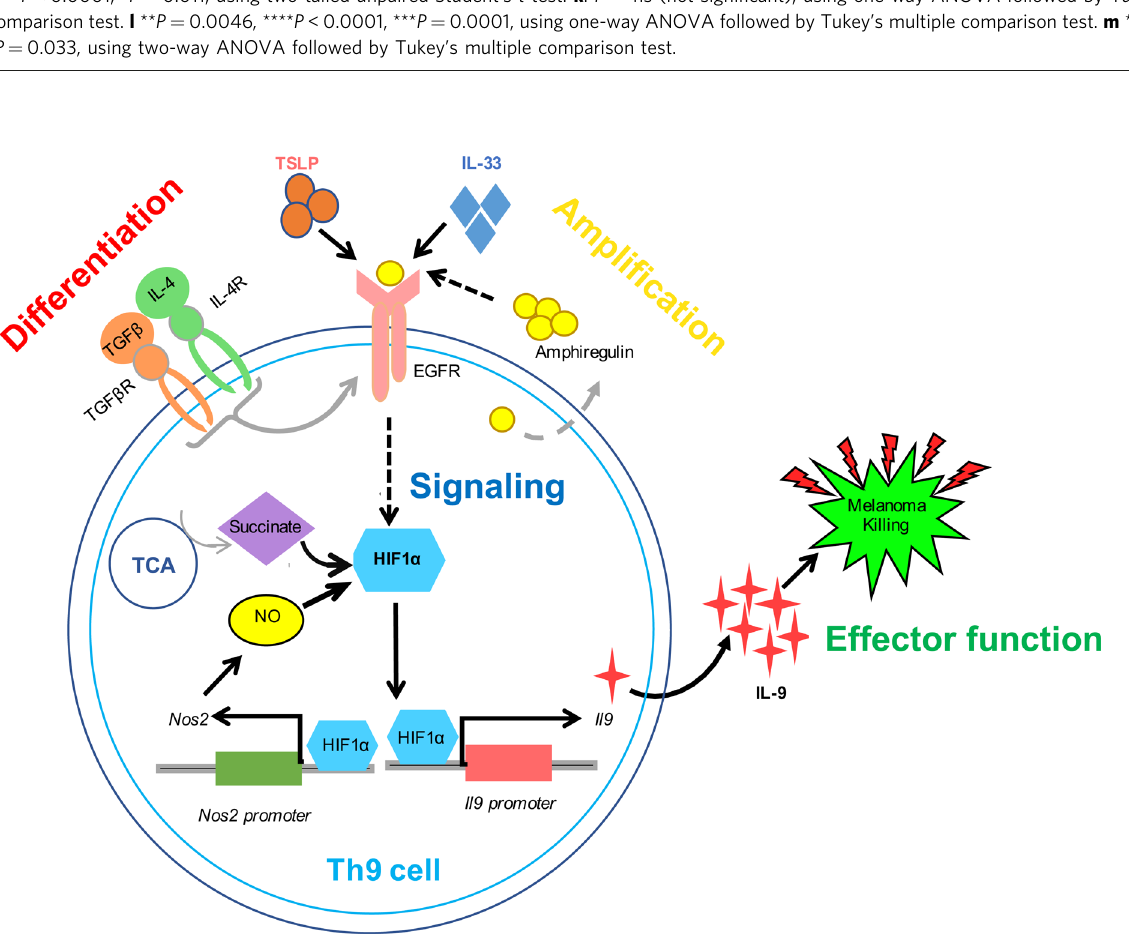
Fig. 7 Succinate enhances HIF1 α -mediated Th9 cell differentiation and anti-tumor immunity. a – e Naïve CD4 + T cells from WT and Hif1 α kd mice were differentiated under Th9 polarizing conditions. Samples were prepared and subjected to metabolomics. Heat-maps showing a global distribution and quanti fi cation of metabolites in the cell extracts; b differentially expressed metabolites of glycolytic pathway; c differentially expressed currency metabolites in cell extract; d footprinting quanti fi cation of differentially expressed metabolites in the cell culture supernatants, and e differentially expressed metabolites of TCA cycle in the cell extracts. f Naïve CD4 + T cells from WT mice were differentiated to Th0 and Th9 with or without 1.0 mM α KG, followed by NanoString analysis of mRNA expression in Th9 and Th9 + α KG conditions. Fold change in relative expression relative to control as determined by log 2 (Th9 + α KG/Th9 WT). g – i Naïve CD4 + T cells from WT mice were differentiated to Th0 and Th9 with or without 1.0 mM α KG followed by g qPCR analysis of Hif1 α and Il9 expression. Data are representative of mean ± SEM from three independent experiments. h FACS analysis of intracellular IL-9 and IL-17 staining, and i mRNA expression of Egln1 . Data are representative of mean ± SEM from three independent experiments. j – l Naïve CD4 + T cells from WT mice were differentiated into Th9 cells with or without 5.0 mM succinate followed by j qPCR analysis of Il9 , Spi1 , Irf4 , Irf1 , and Gata3 expression. k FACS analysis of intracellular IL-9 and IL-17 production and ELISA for IL-9. l qPCR analysis of Hif1 α and Egln1 mRNA expression. Data are representative of mean ± SEM from three independent experiments. m Naïve CD4 + T cells from OT-II TCR transgenic mice were differentiated into Th9 cells with or without 5.0 mM succinate. At day 4, cells were adoptively transferred into B16-OVA tumor-bearing WT mice. Mean tumor volume was measured over time. Data represent one of the three experiments with three independently analyzed mice/group ( n = 3 mice per group). g * P = 0.009, using one-way ANOVA followed by Tukey ’ s multiple comparison test. i ** P = 0.004, using two-tailed unpaired Student ’ s t test. j ** P = 0.0027, *** P = 0.0002, **** P < 0.0001, * P = 0.011, using two-tailed unpaired Student ’ s t test. k . P = ns (not signi fi cant), using one-way ANOVA followed by Tukey ’ s